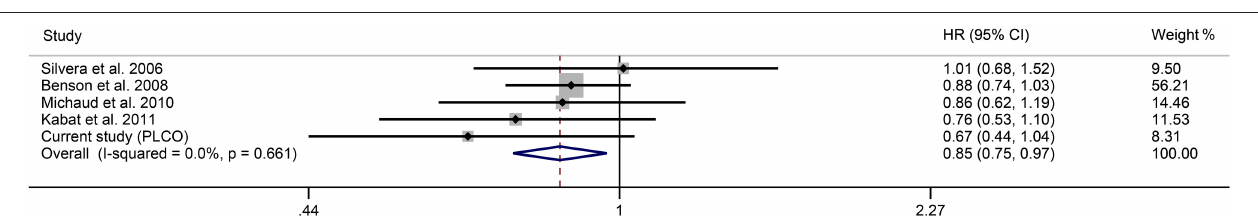
FIGURE 3 | Forest plots for the relationship between OC use and glioma risk. OC, oral